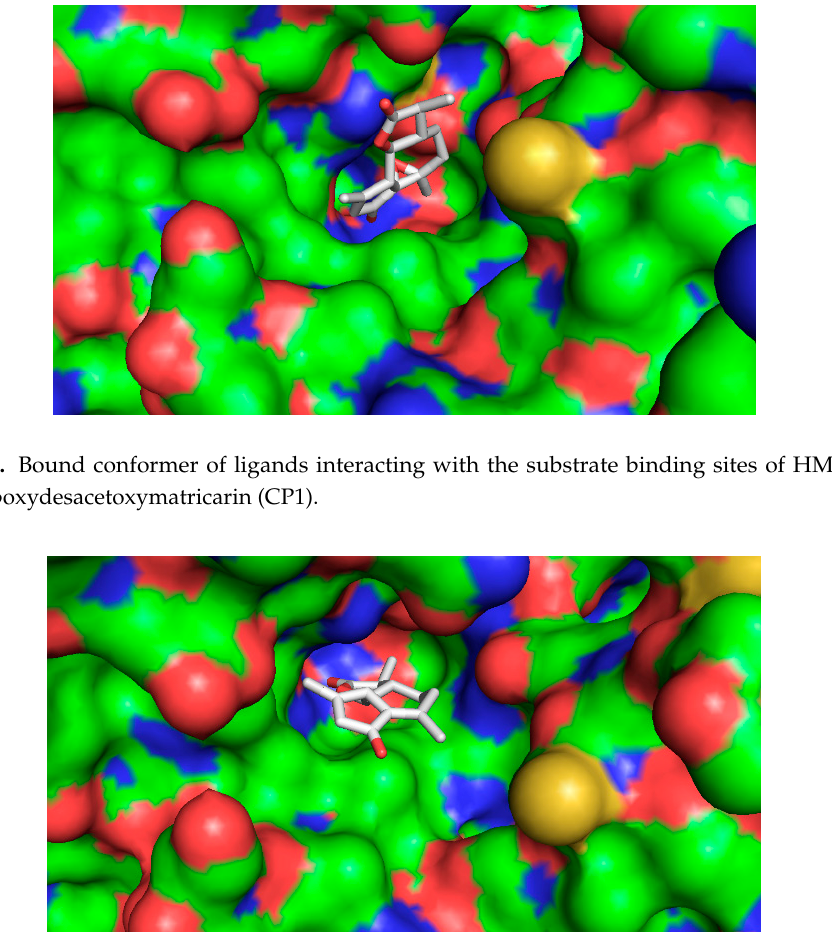
Figure 12. Bound conformer of ligands interacting with the substrate binding sites of HMGR (atorvastatin).